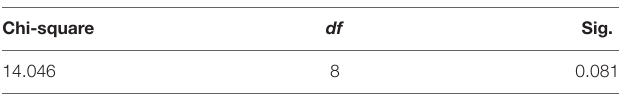
TABLE 6 | Hosmer and lemeshow